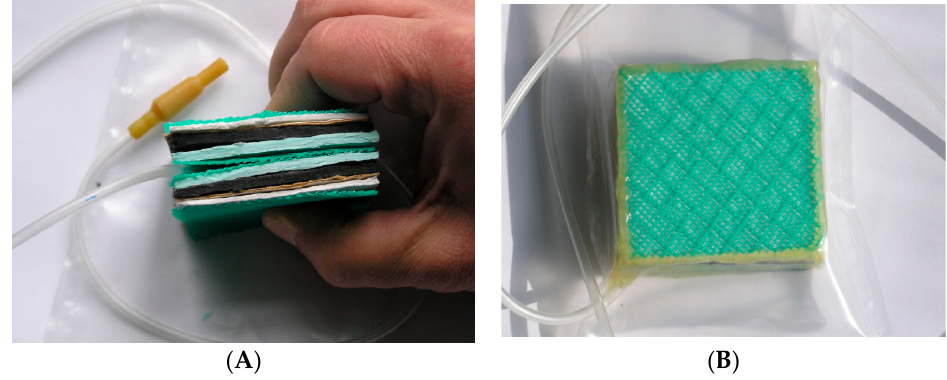
Figure 9. Membrane package ( A ) and the assembled filter ready for operation (B).